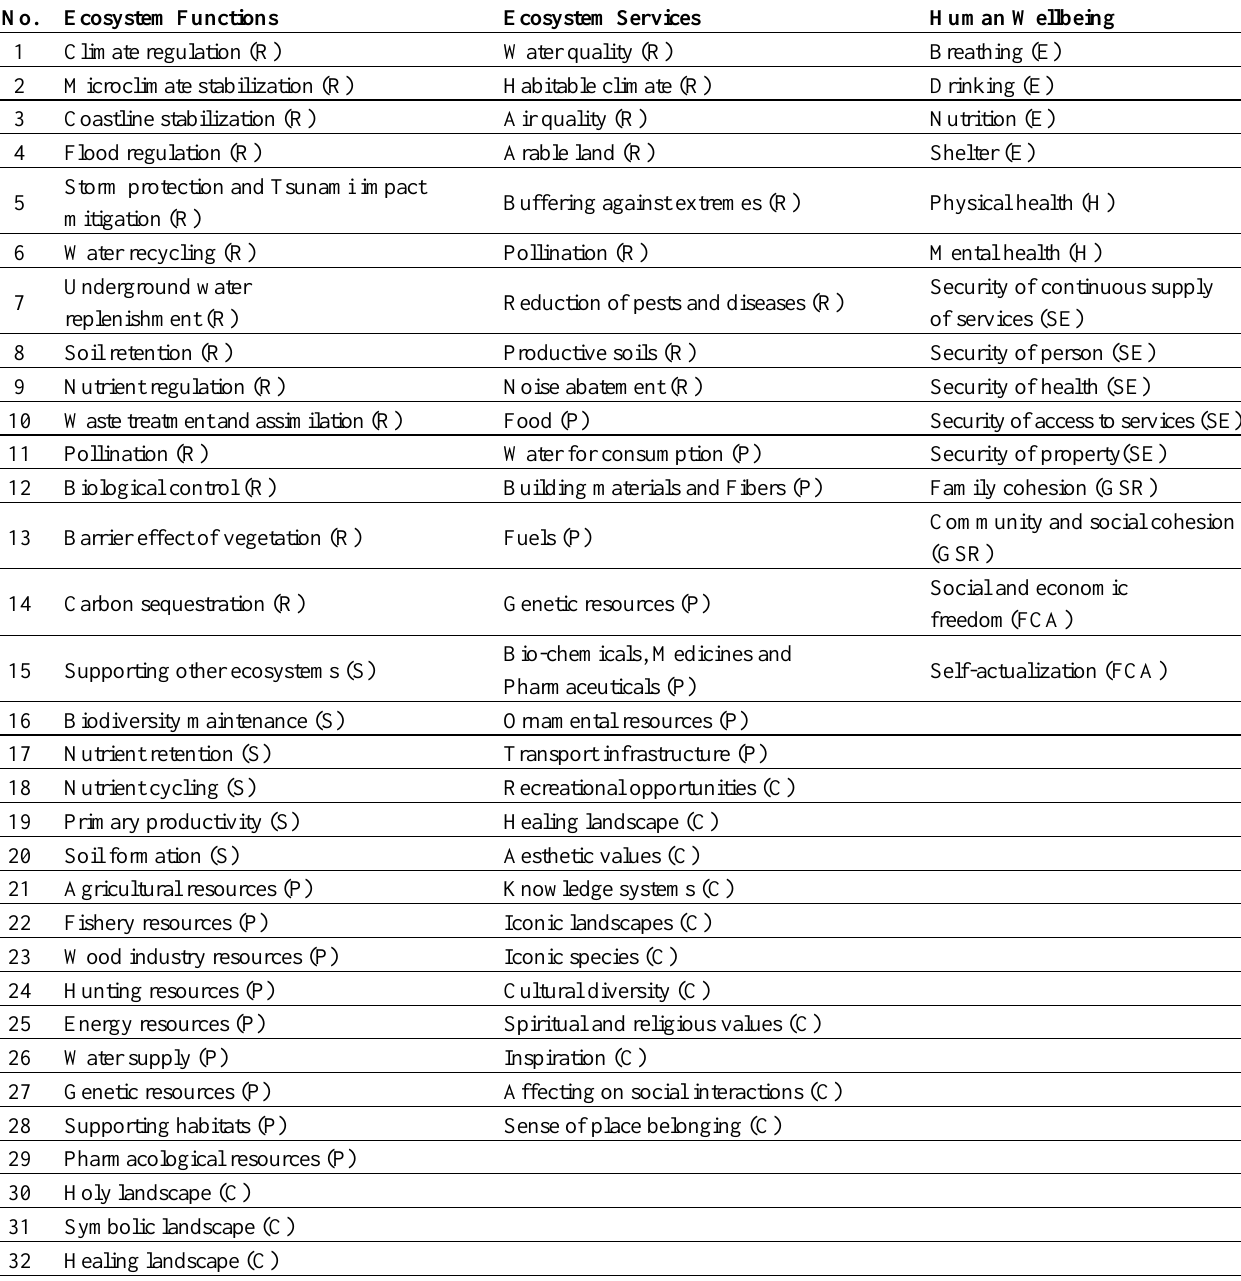
Table 1. The components of ecosystem functions, services and human wellbeing assessed for the Danshuei estuarine mangrove system. In the first two columns, the letter notations shown in parentheses indicate the Category to which each constituent